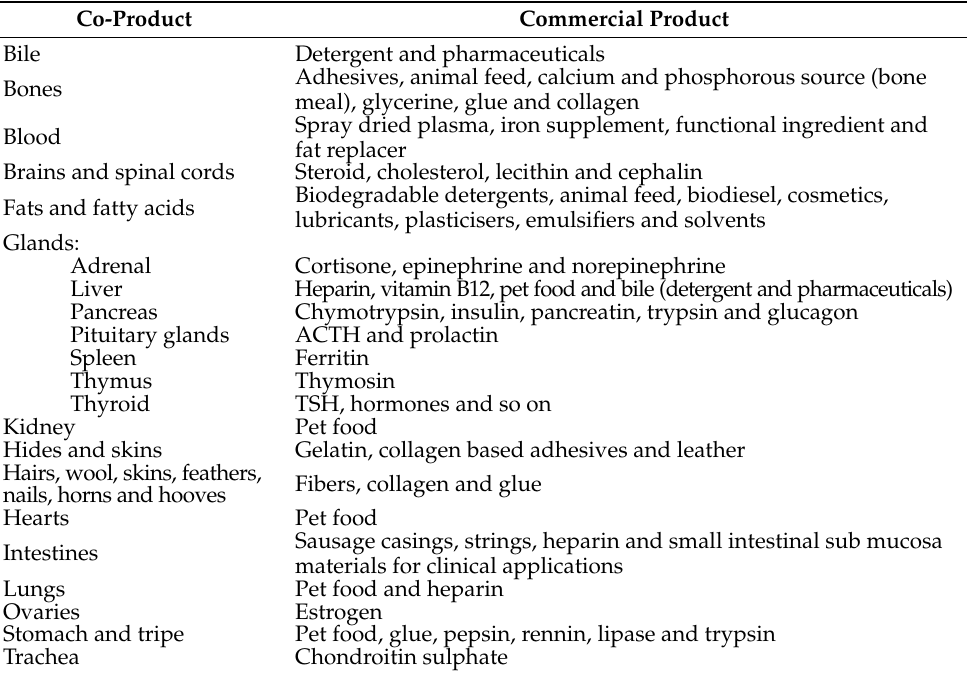
Table 6. Animal co-products current uses: industrial products and pharmaceuticals